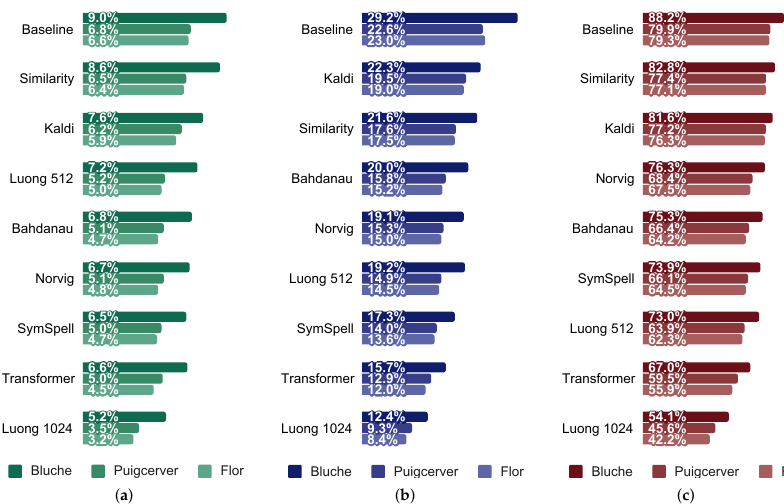
Figure 11. Error rates in the All in One dataset (lower is better), ( a ) Character Error Rate (CER); ( b ) Word Error Rate (WER); ( c ) Sequence Error Rate